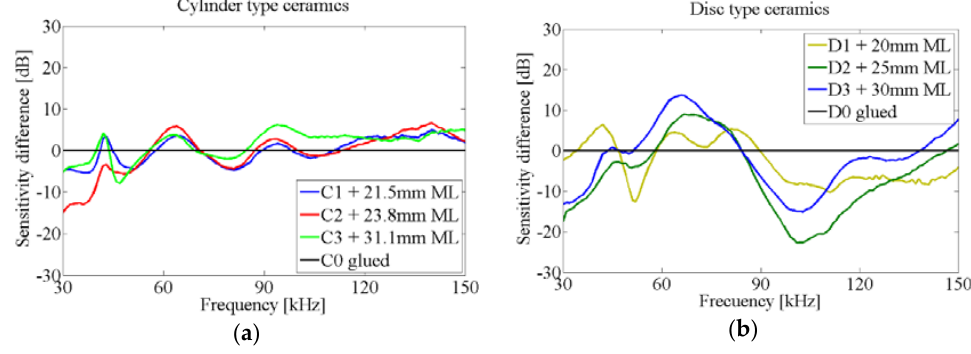
Figure 14. Difference of sensitivity in ceramics glued to the vessel, with and without ML. ( a ) Cylinder type ceramic; ( b ) Disc type ceramic.